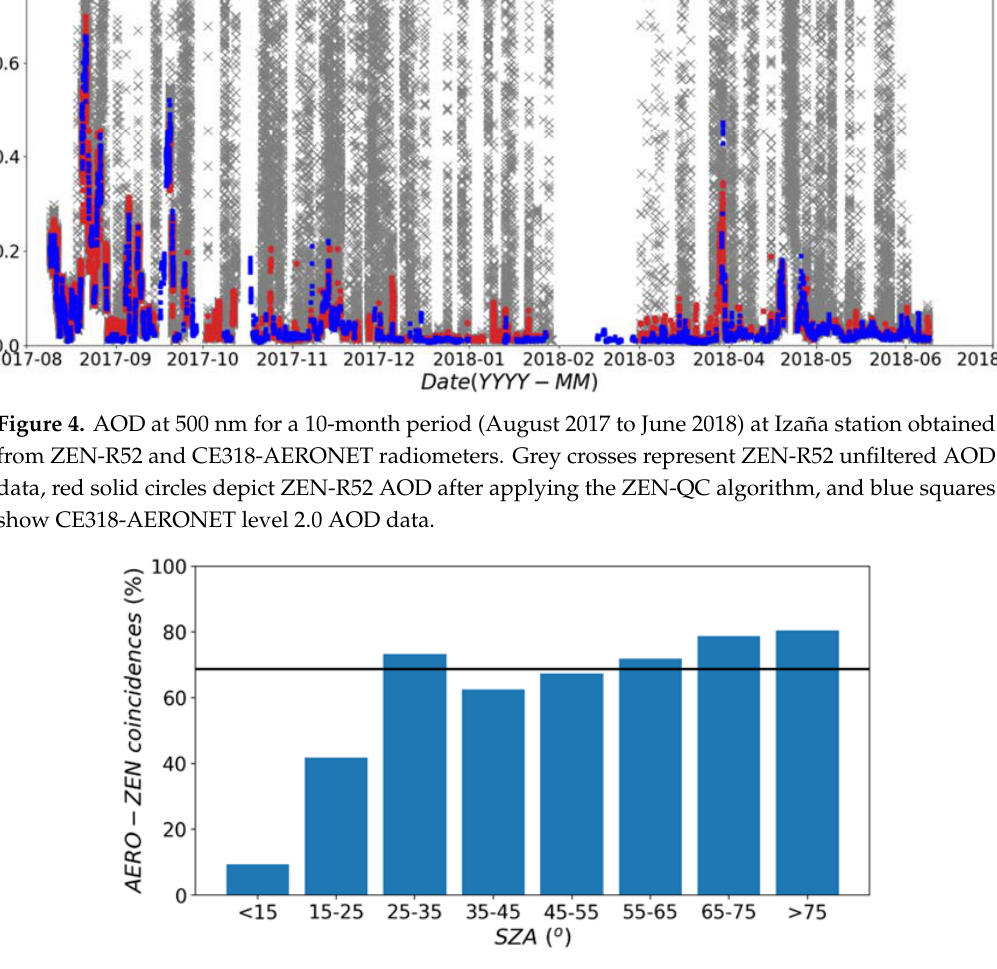
Figure 5. Coincidences (%) between AERONET and ZEN quality control algorithms for eight solar zenith angle (SZA) intervals. The black line represents the average of 68.8% of the coincidences.